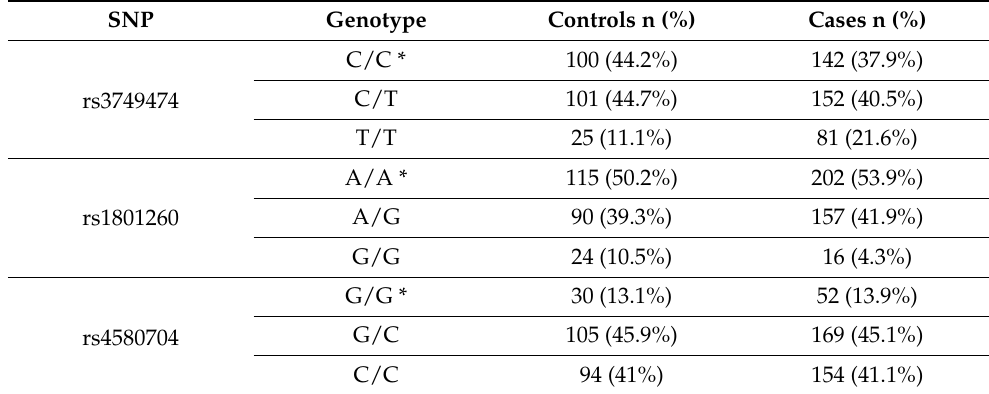
Table 1. Absolute and relative frequency of genotypes of the included CLOCK gene variants. SNP Genotype Controls n (%) Cases n